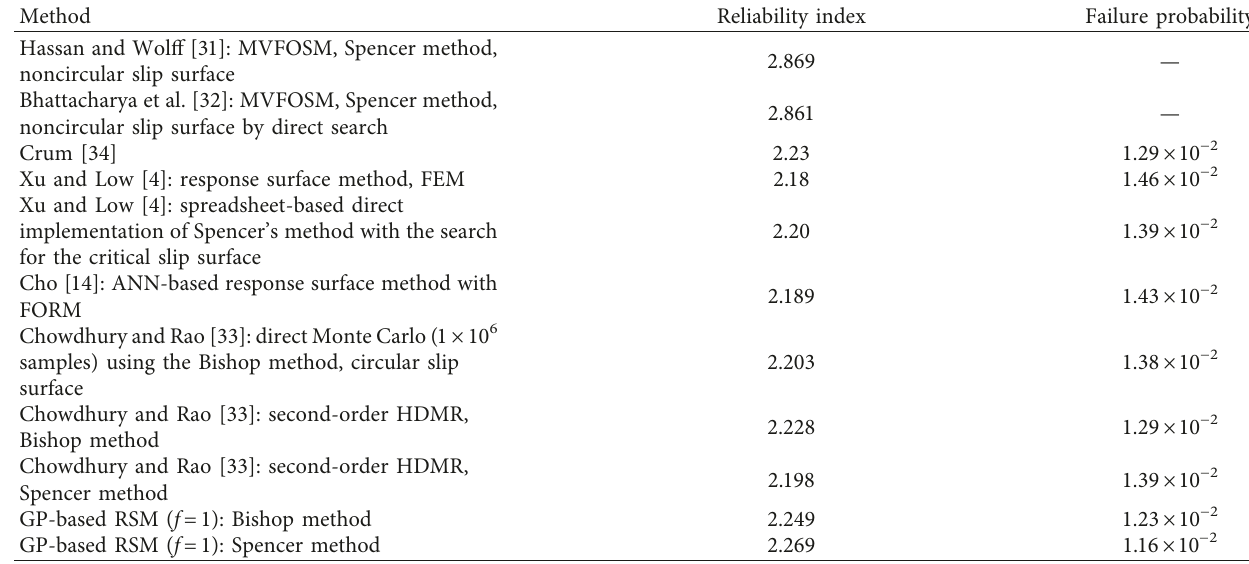
Table 6: Results of probabilistic analysis from different methods for Example 2.